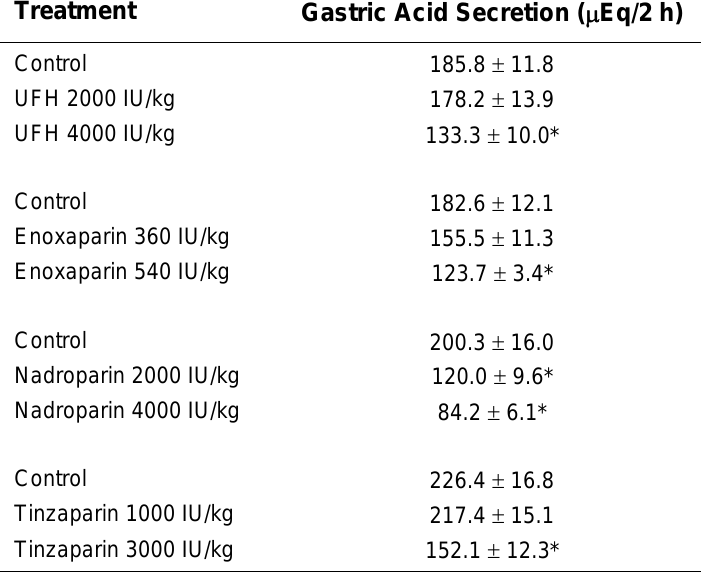
Inhibition of Gastric Acid Secretion Stimulated by Distention and Histamine (5 mg/kg, i.p.) by UFH and LMWHs